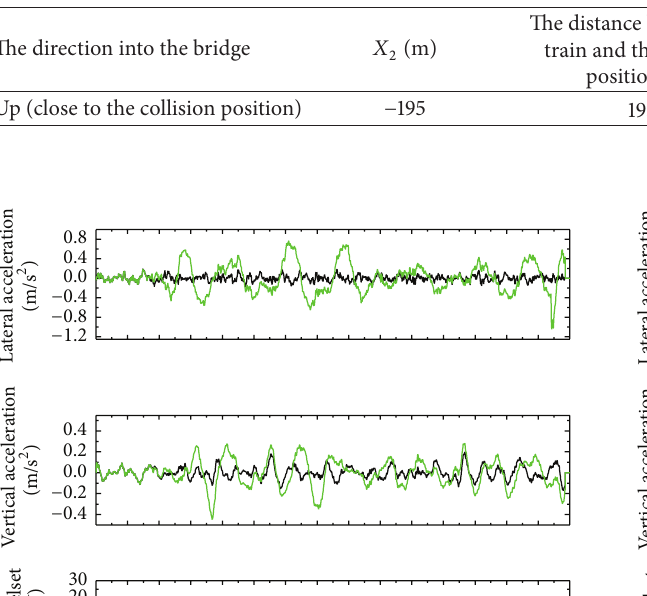
Table 3: Calculation condition of a train (in the up direction).